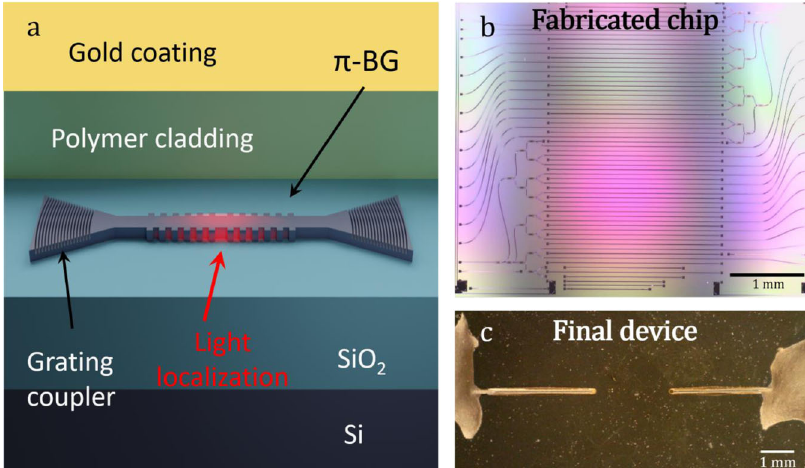
Fig. 2 SPADE: Silicon-photonics acoustic detector. a Illustration of the silicon-photonics layer structure and the structure of π -phase-shifted Bragg grating ( π -BG) with grating couplers. b Photograph of the silicon-photonics chip prior to fi ber bonding. c Photograph of the assembled and gold-coated silicon- photonics chip.